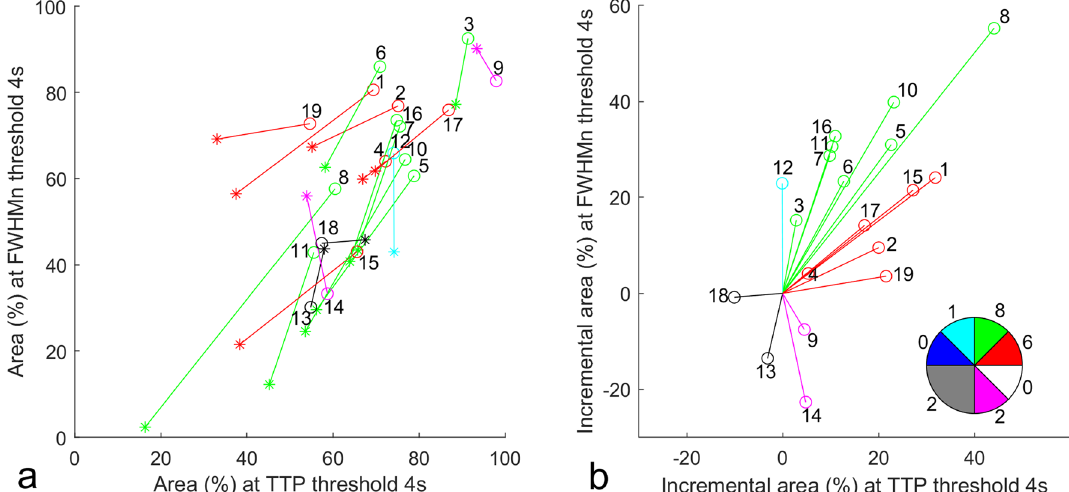
Figure 2. ( a ) TTP and FWHM n of 19 patients of the earliest (star) and latest clean scans (circle) at threshold under 4 s (in percentage of the convexity area). ( b ) The earliest points (star) are rearranged to locate at the origin to show area increments (latest–earliest). All the vectors in ( a ) and ( b ) are color-coded according to the vector angle illustrated in the pie chart in (b). Patient number is marked next to the circle of each vector, and the population of vectors in each color is given around the pie